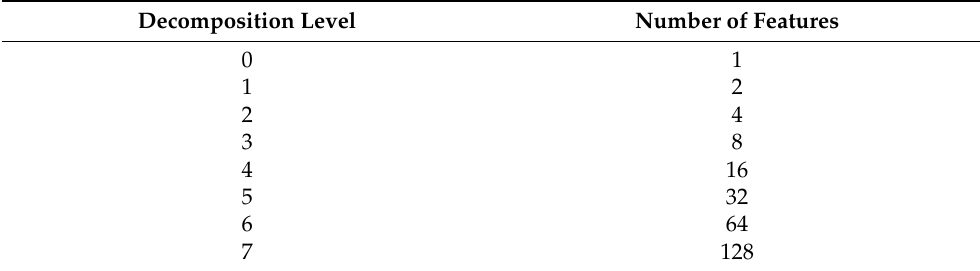
Table 5. Number of features extracted by WPD with respect to decomposition level. Decomposition Level Number of